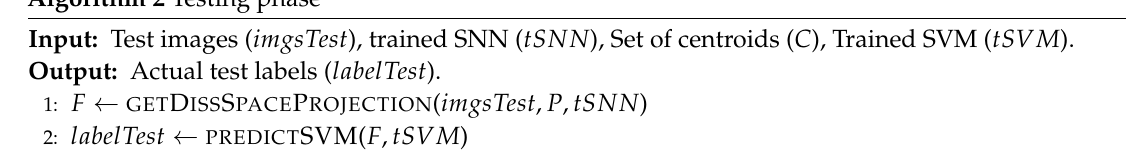
Algorithm 2 Testing phase